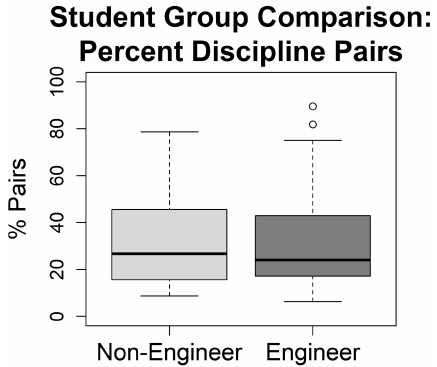
Fig. 6. Representative chart illustrating first-year engineering and non-engineering students’ data are similar (% pairing for discipline framework shown here). In all quantitative metrics, no statistical difference was found between these groups (p-values ≅